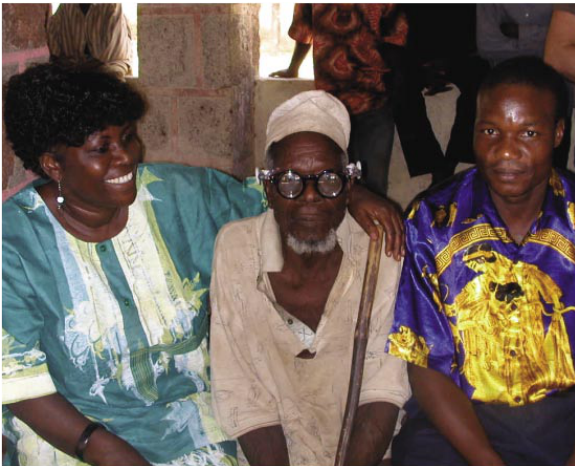
Figure 11 . A satisfied learner wearing his